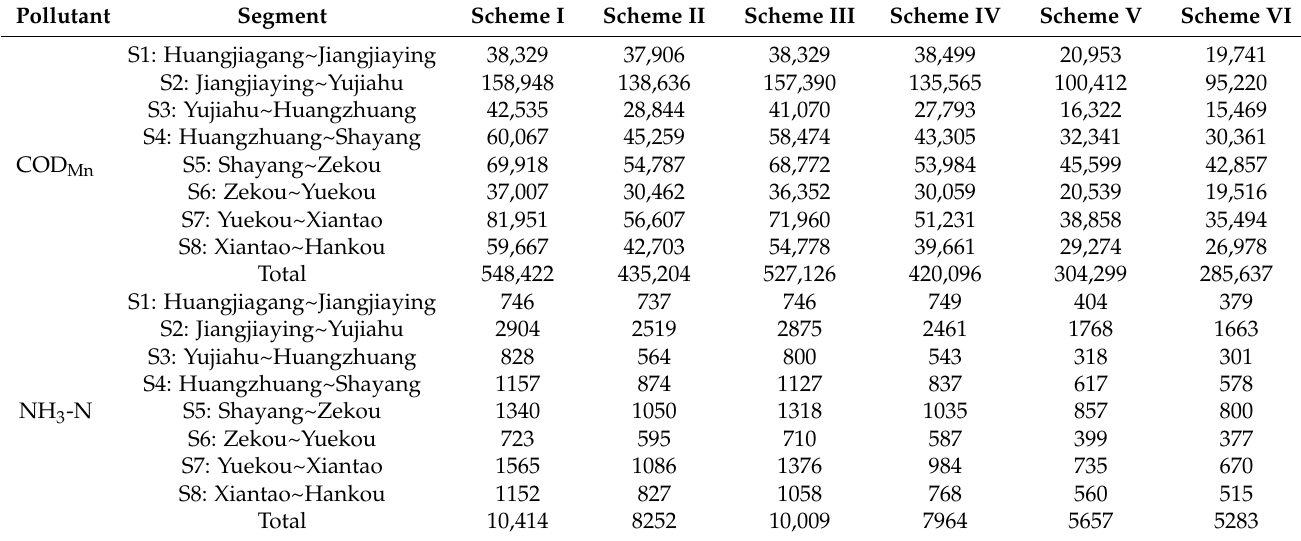
Table 8. The WEC of COD Mn and NH 3 -N in eight river segments (t/a).